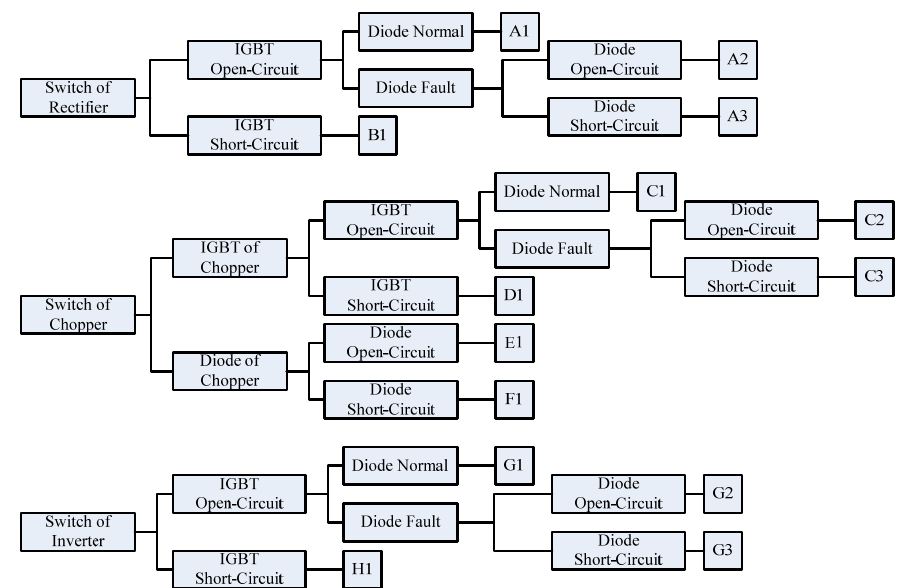
Figure 5. Catalogue of fault